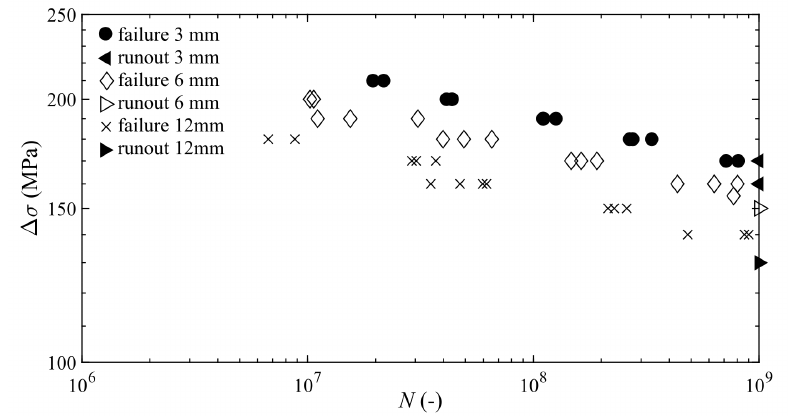
Figure 7. S-N diagram of the experimental data.